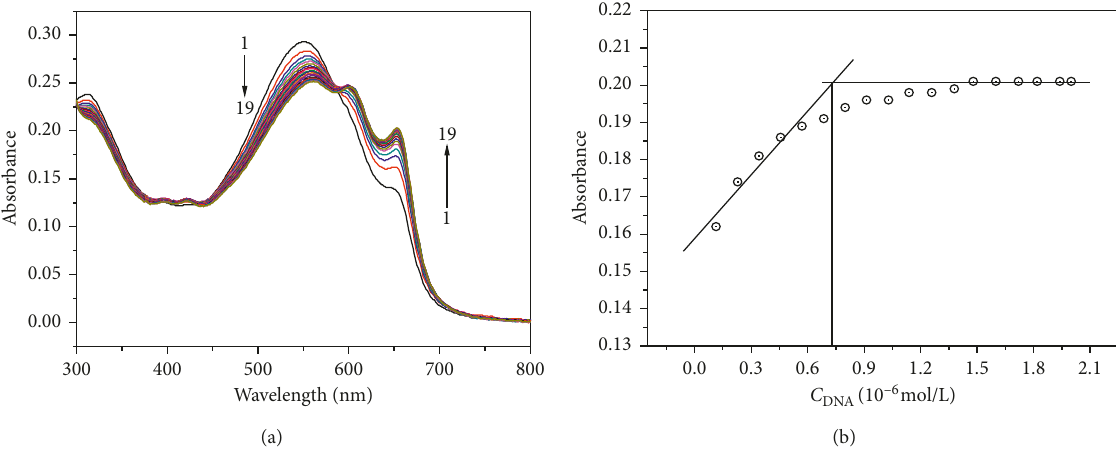
5 mol 1 ; c 5 10 L Thulium (III) (cid:31) 1 × 10 (cid:31) × · − −